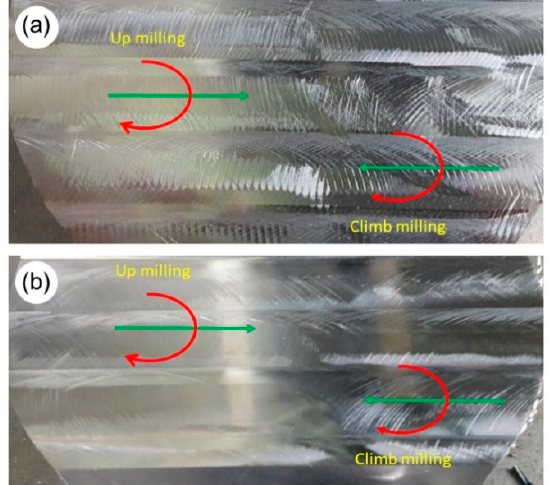
Figure 12. Surface integrity after milling using: ( a ) HF face cutter, ( b ) face cutter with the entering angle of 𝜅 r = 45°.